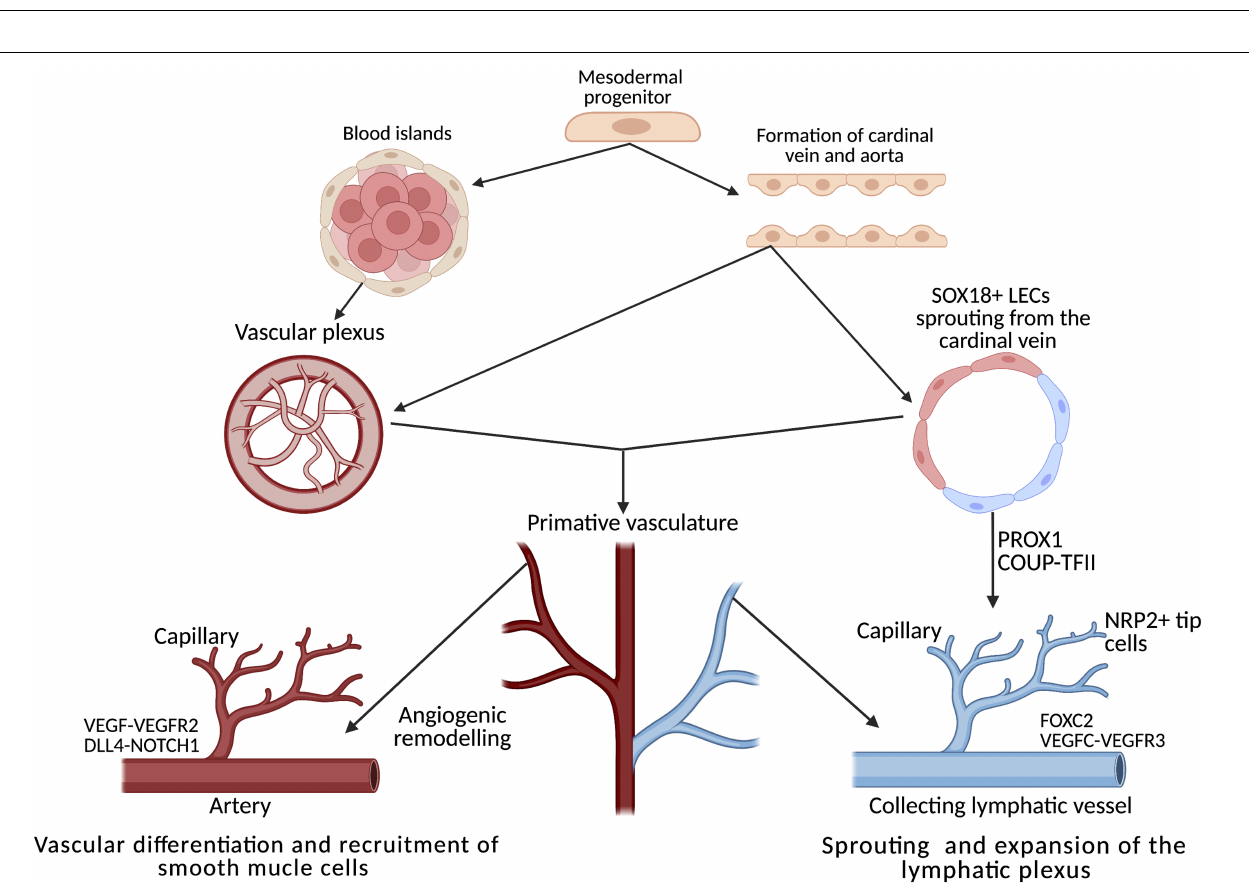
FIGURE 1 | Comparison of a lymphatic collecting vessel and a lymphatic capillary. Further to lumen calibre differences, additional features of collecting vessels include pericyte coverage, a layer of smooth muscle cells and the presence of valves to prevent backflow. Capillaries have discontinuous junctions between endothelial cells, these act as sights of leukocyte entry and increase the permeability of the vessel. Additionally, capillaries are connected to the extracellular matrix by anchoring filaments, these become taut in places of swelling, opening the lumen to allow drainage of tissue fluid. Adapted from Tammela and Alitalo (2010). Made with Biorender.com.